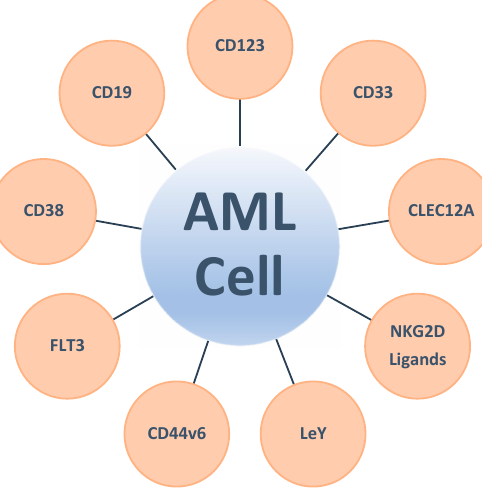
Figure 2. Currently clinically exploited targets for CAR-modified IEC therapy in AML.